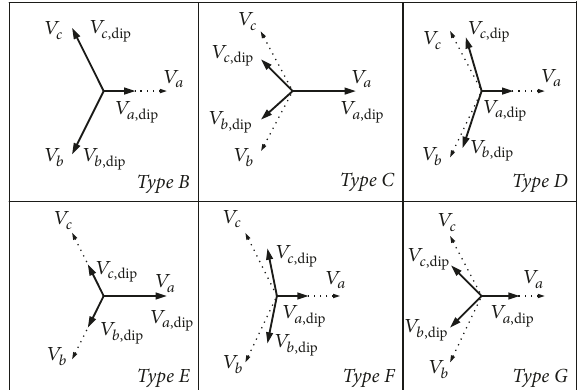
Figure 3: Fault types B to G [6].